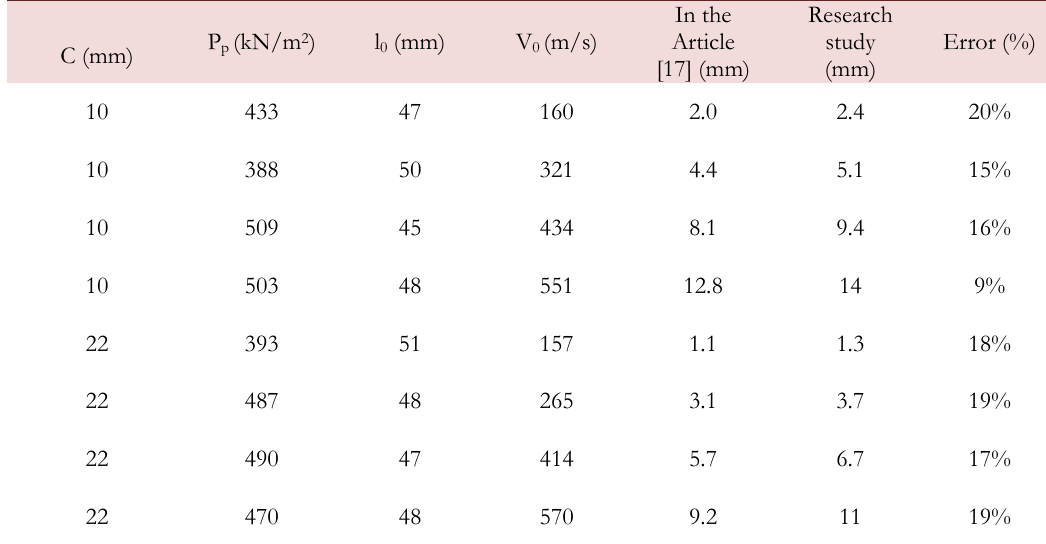
Table 11: Comparison of experimental and simulation